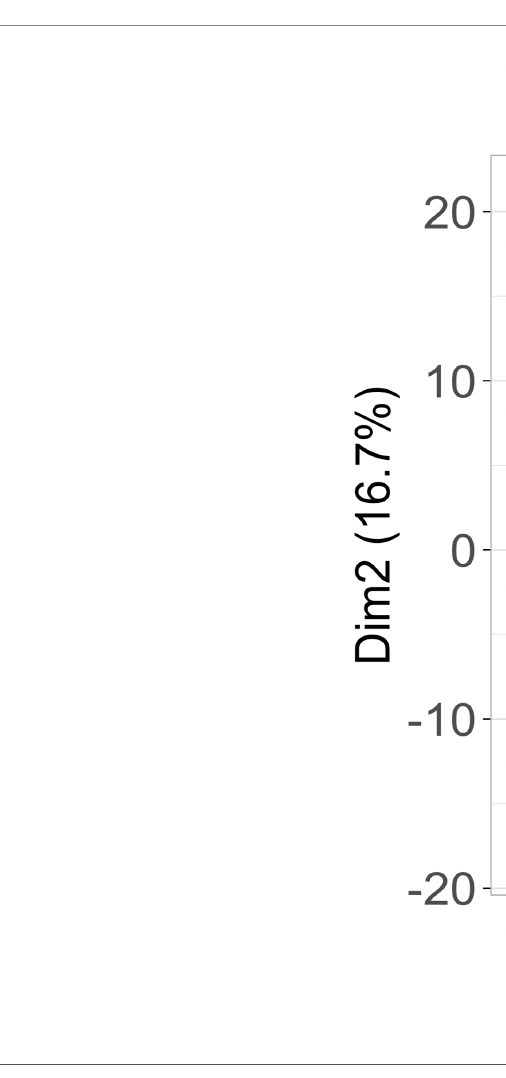
Figure A1. Cluster analysis of patients (pt) after JAKinhibs treatment and healthy control-group subjects (HC). Cluster analysis results (K-means clustering) considering 500 most variable protein coding genes across all samples that divide subjects into subgroups by similarities. Each dot represents a subject; Dim1 and Dim2 show the higher di ff erences between the main clusters; D-Cluster contains three HC and patients #2, #3, #5, #6. H-Cluster 3: three HC and patient #4. Patient #1 and patient #7 are